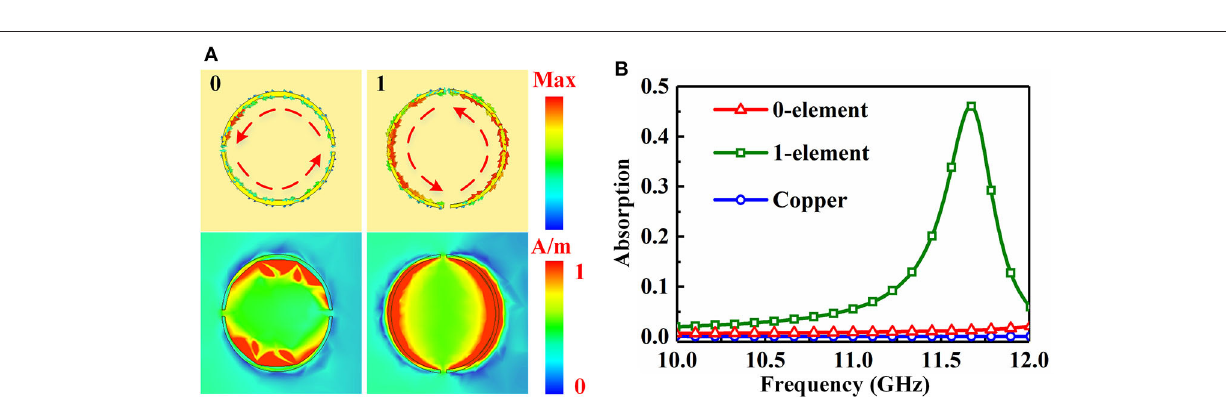
FIGURE 4 | (A) The surface current and magnetic field of two coding elements at 11.16 GHz. (B) The absorption of two coding